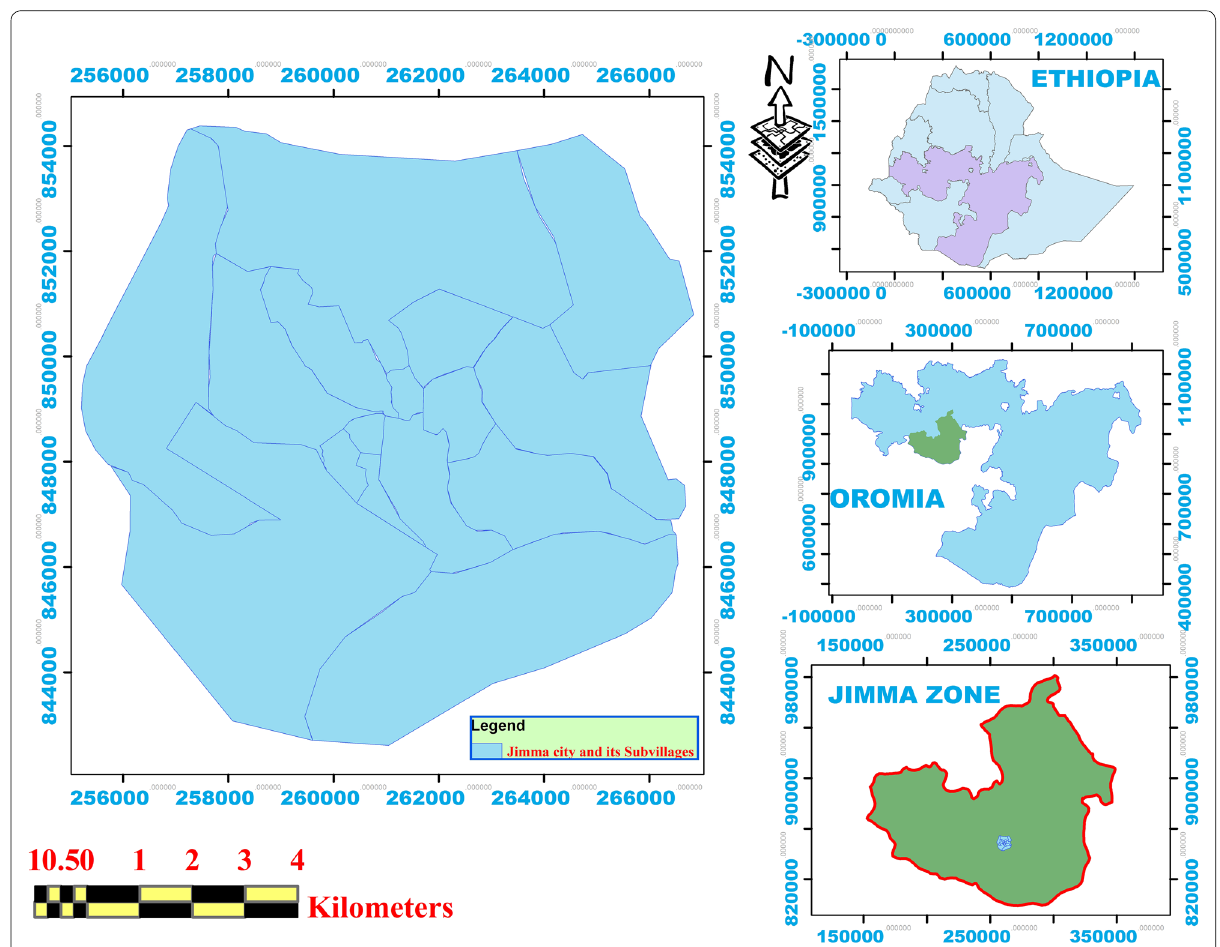
Fig. 1 Map of the study